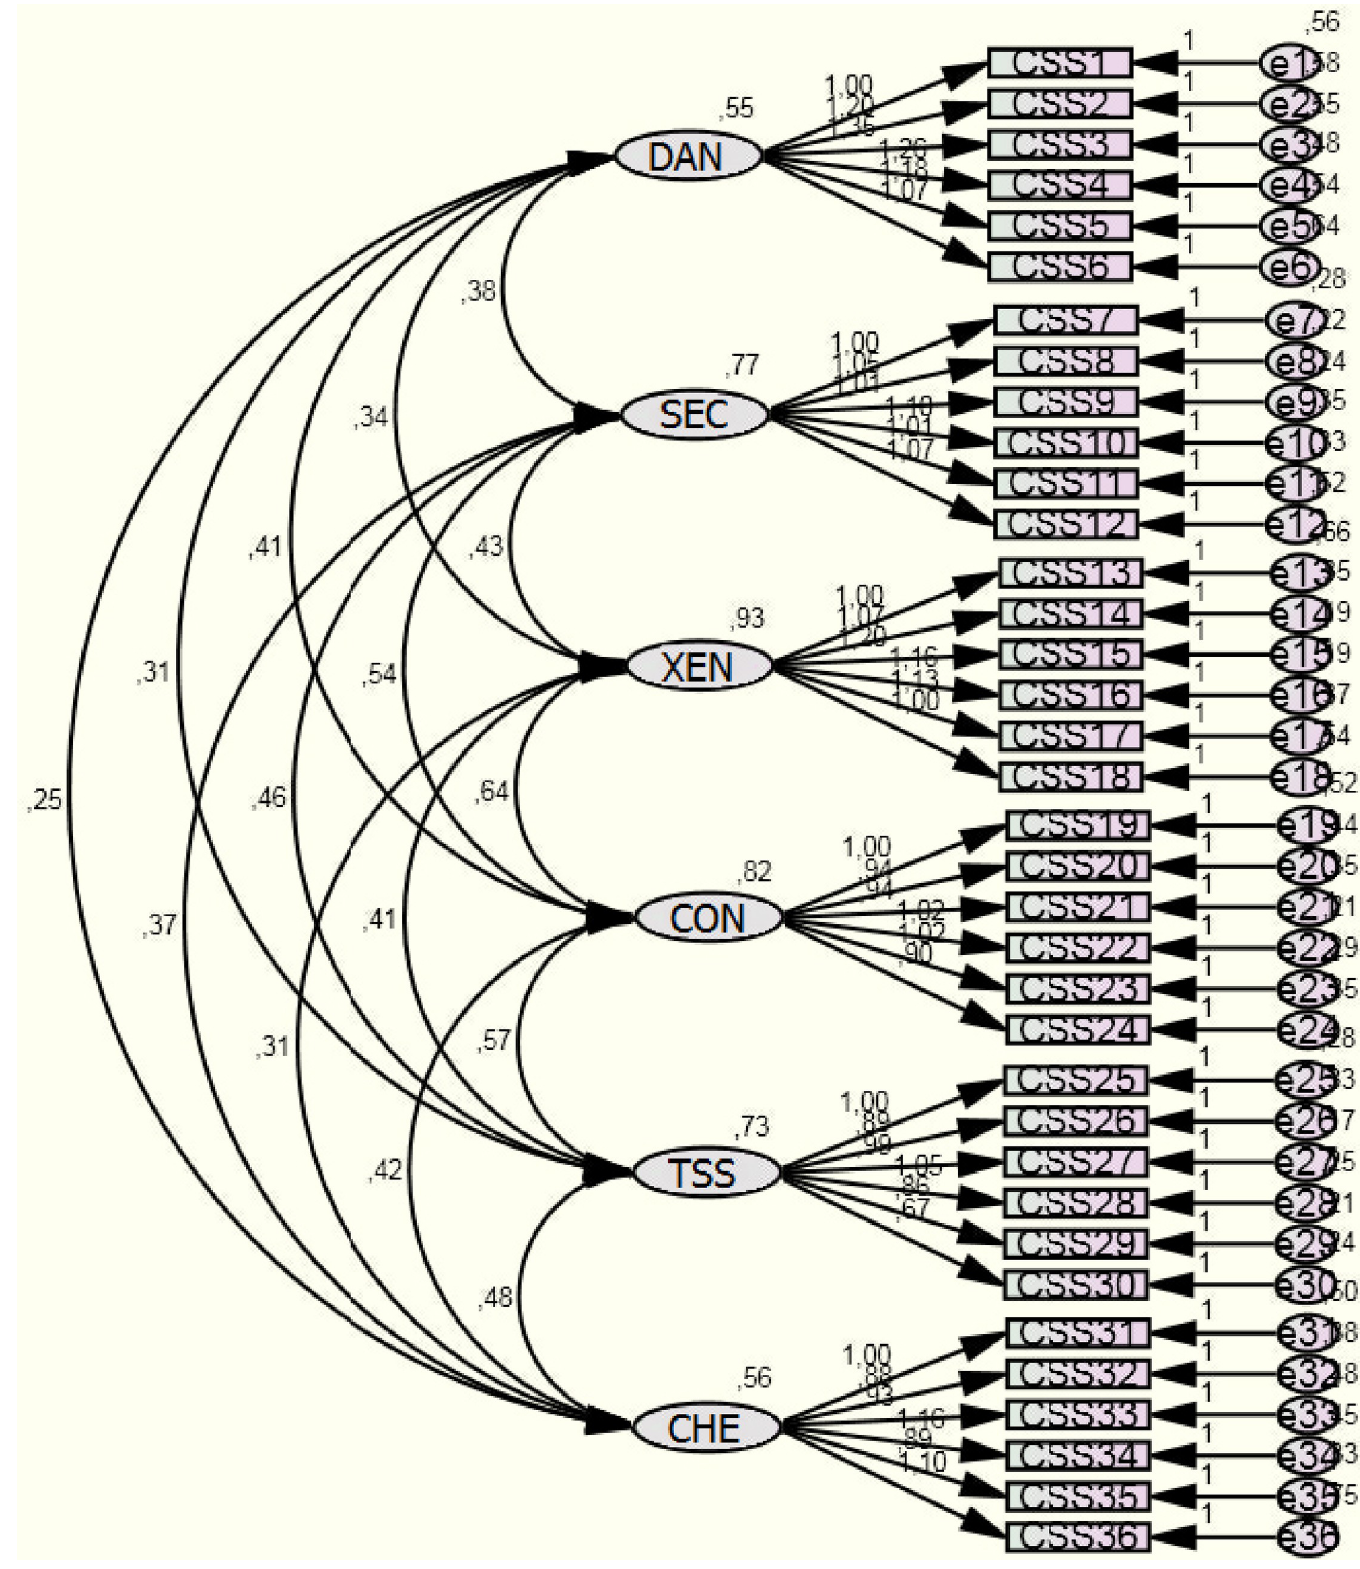
Fig 1. Confirmatory factor analysis for COVID Stress